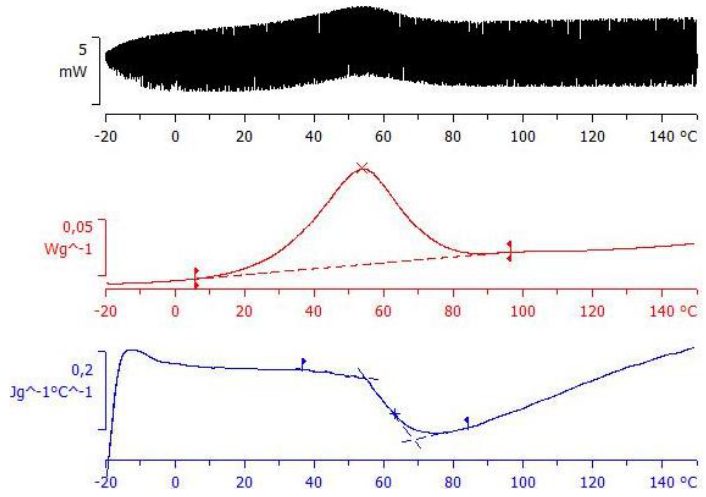
Figure 11. TOPEM thermogram of ELP at an underlying heating rate of 0.5 K/min: top diagram shows the stochastically modulated heat flow; middle diagram shows the total heat flow; bottom diagram shows the “quasi-static” specific heat capacity, c p0 . Materials 2016 , 9 , 192